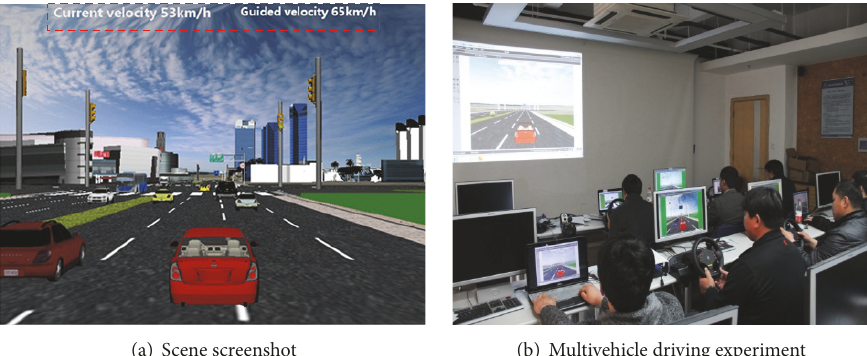
Figure 5: Multivehicle driving simulator based experiments.